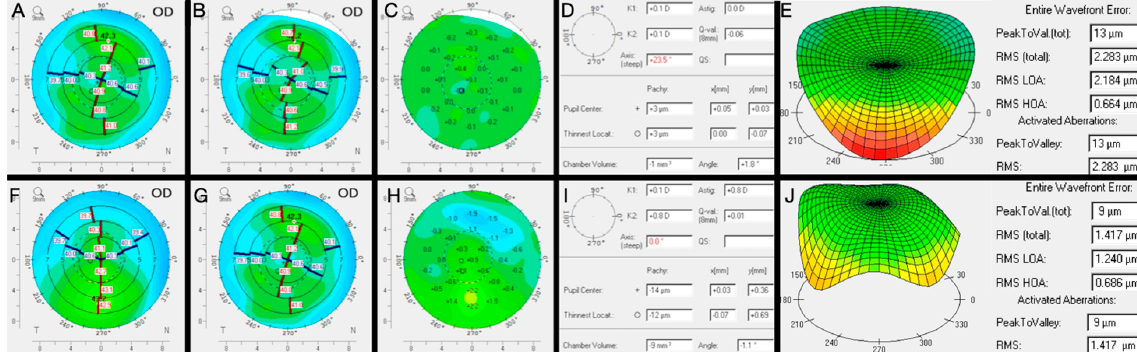
Figure 3. The impact of tear film stability on corneal topography. Sequential same day ( A , B ) Scheimpflug image in the setting of unstable tear film demonstrating a difference ( C ) of 23.5 diopters on the axis of astigmatism ( D ). In addition to varying magnitude and axis of astigmatism, tear film instability also results in increased wavefront error ( E ). Repeat topography after GOLD optimization reveals a more regular astigmatism with less same day variability ( F , G ). The best fit topography prior to GOLD optimization ( A ) was compared to ( F ) which revealed a 0.8D increase in magnitude in astigmatism ( H , I ) as well as a decrease in wavefront error ( J ). Multifocal and extended depth of focus (EDOF) presbyopia-correcting IOLs provide the greatest change for spectacle independence following cataract surgery but are exquis- sion than monofocal patients (Figure 4) [8–10]. These patients should be specifically coun- seled that GOLD optimization will remain paramount after surgery for the best possible outcome.